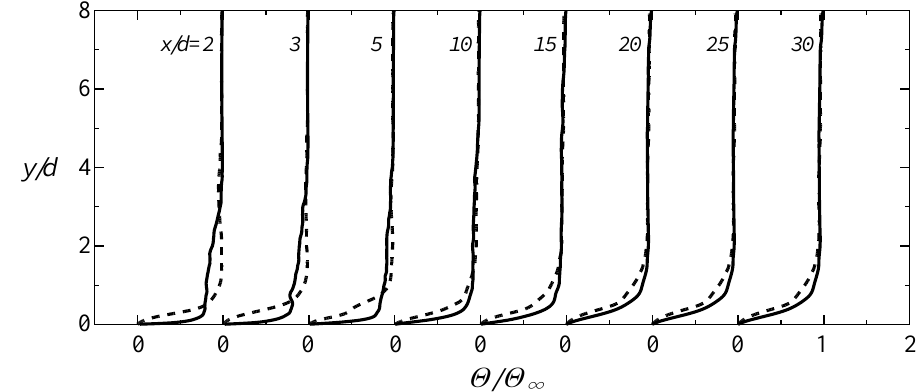
Fig. 5 Mean temperature profile. Solid line: 25.0/  dC ; dash line: 0.3/  dC .